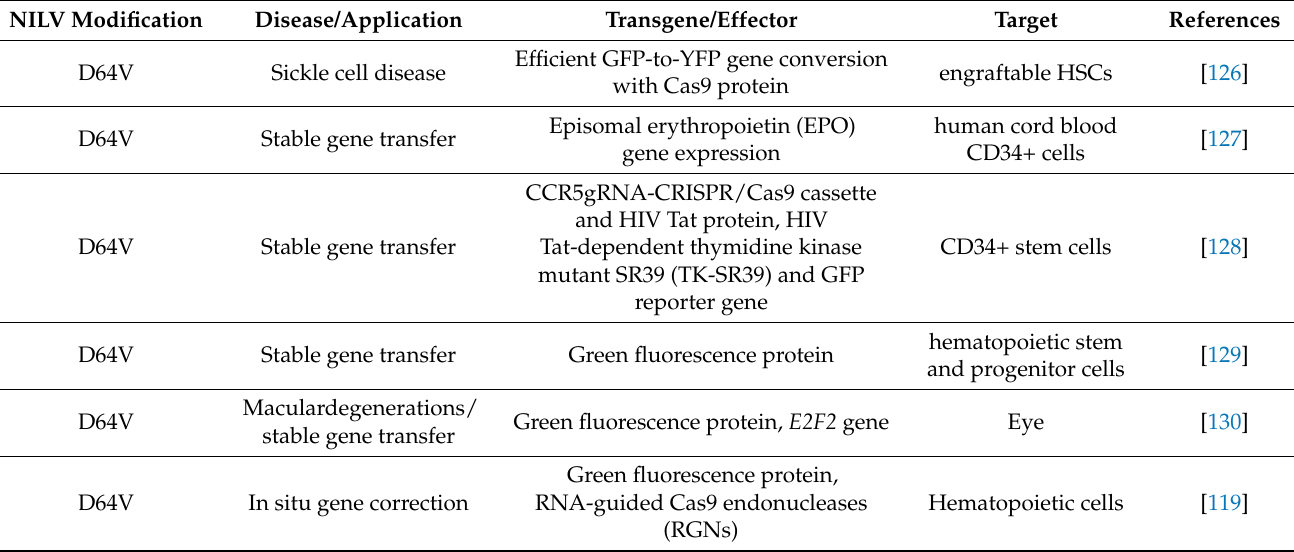
Table 8. Summary of integrase mutations with added elements used in developing non-integrating lentiviral vectors (NILVs) for gene therapy in pre-clinical studies with specifically targeted